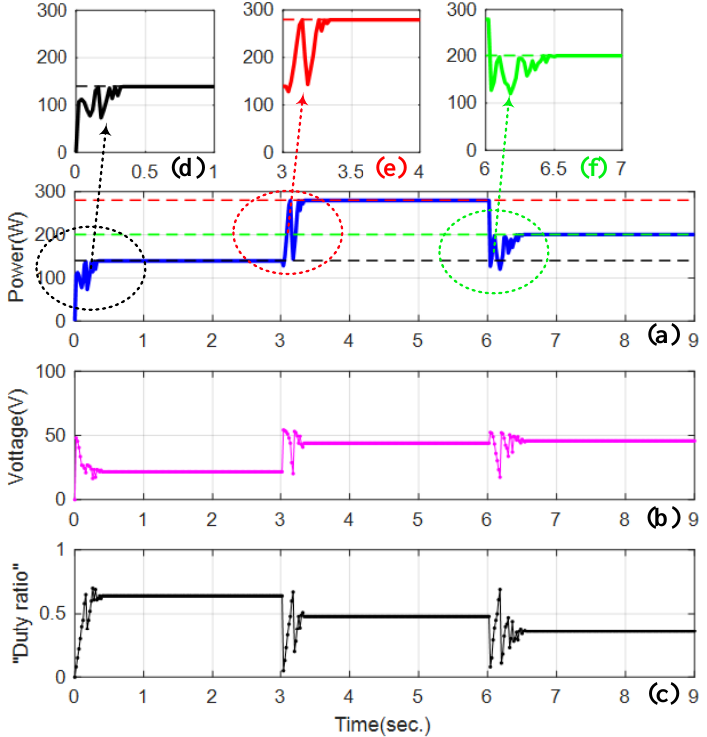
Figure 13. Results of the proposed HRA method for two serial panels. ( a ) PV power, ( b ) PV voltage, ( c ) duty ratio, and ( d – f ) transient trajectories for situations 1 – 3, respectively. (Black --, red --, green --: global maximum values of situations 1 – 3). Table 4. Comparison of simulation results between three MPPT methods for two cases.